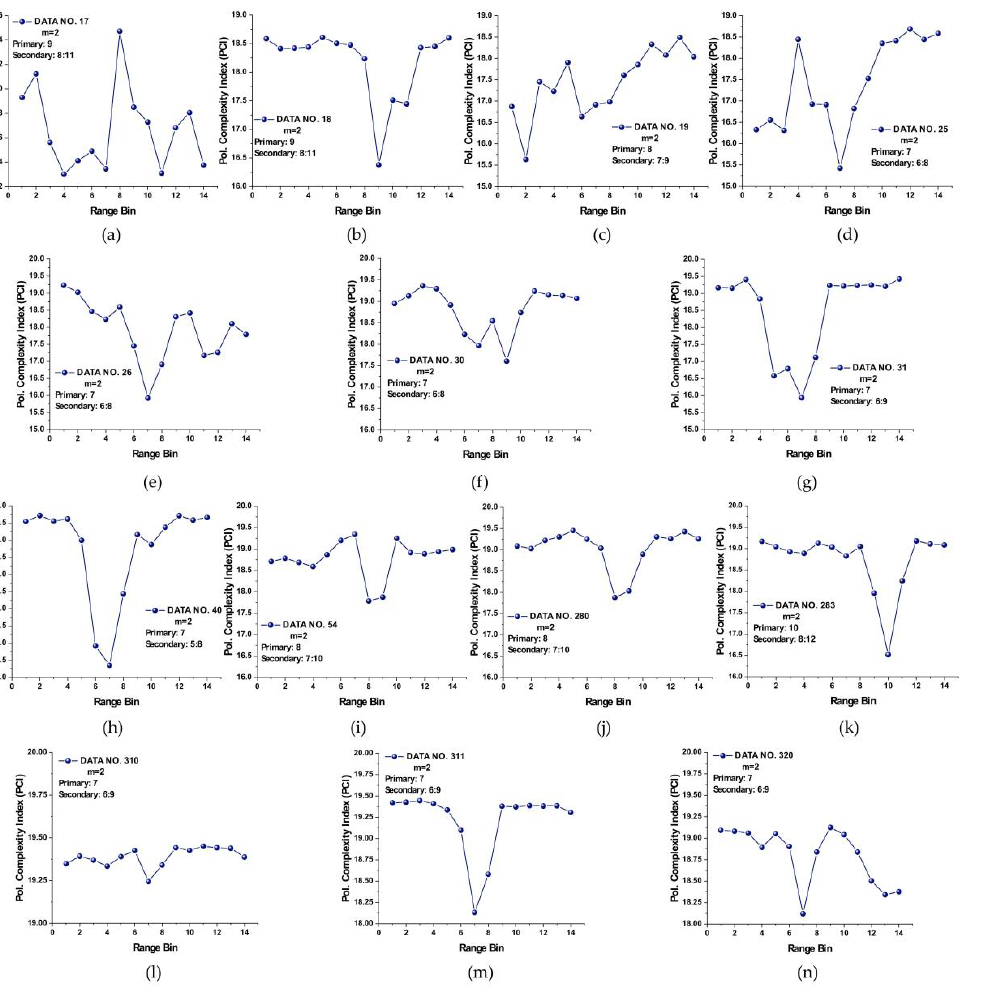
Figure 10. ( a – n ) PCIs of 14 data sets at template vector length m = 2 · ( τ = 20, r = 0.15 ∗ std { s } )